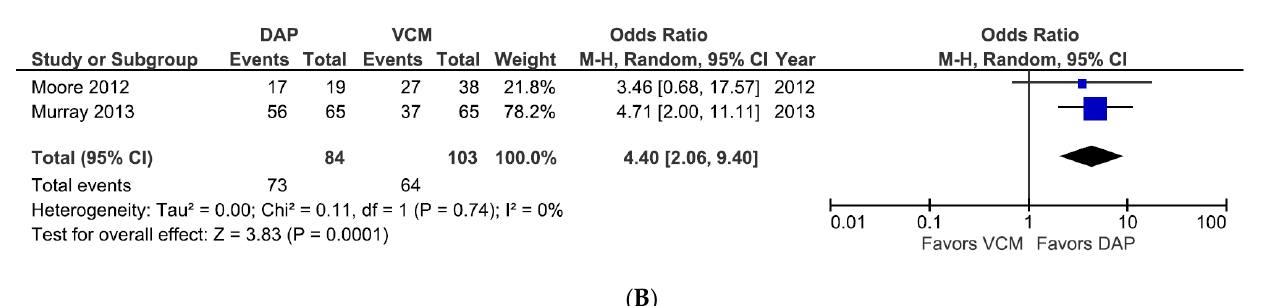
Figure 3. Forest plots of treatment success rates for patients treated with DAP versus VCM for bac- teremia caused by MRSA with VCM MIC > 1 µg/mL, according to the infection risk level. ( A , B ) Forest plots of treatment success rates of patients treated with DAP versus VCM for intermediate- risk ( A ) and high-risk ( B ) sources of infection. Symbols and abbreviations are as described in Figure 2.